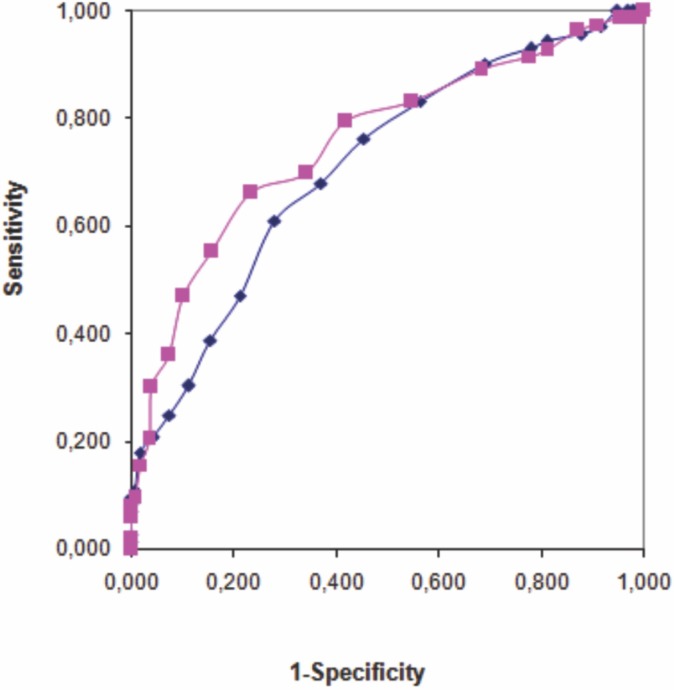
ROC curve for HbA1c values in diagnosing GDM.Blue Line—HbA1c vs WHO 1999 N = 262, Red line—HbA1c vs ADA/WHO 2013* N = 142. * After June 2011.